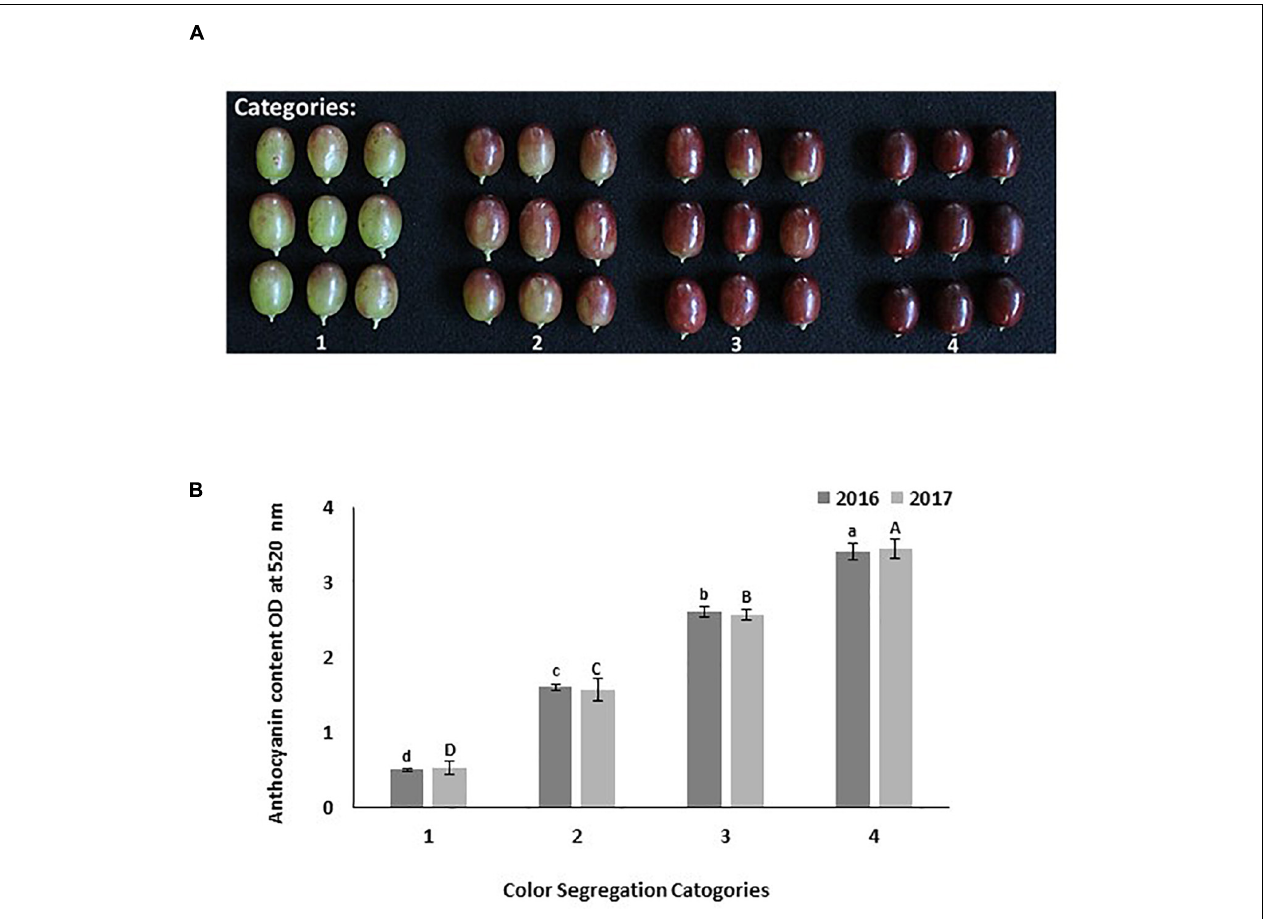
FIGURE 1 | Different categories used to evaluate Scarlet Royal grapes color visually at harvest time. Categories are: 1 = 25% red color; 2 = 50% red color; 3 = 75% color (bright red colored berries with green shoulder); 4 = 100% color (dark red colored berries with no green shoulder) (A) . The total anthocyanin content in each color category as measured spectrophotometrically in 2016 and 2017 (B) . The error bars represent the standard deviation. Different letters on bars indicate significant differences among categories within the same year at p < 0.05 according to the Tukey HSD test within the same season. Different lower-case letters indicate a significant difference among categories in 2016 while capital letters are used for